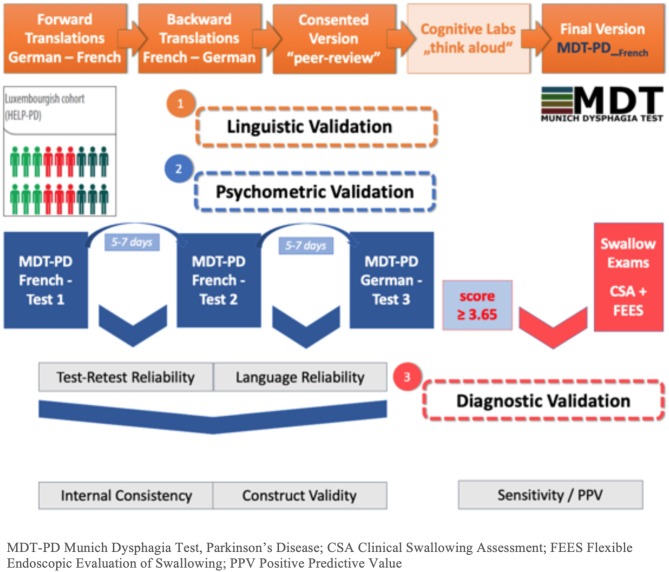
Flowchart of study phases. MDT-PD, Munich Dysphagia Test–Parkinson's Disease; CSA, Clinical Swallowing Assessment; FEES, Flexible Endoscopic Evaluation of Swallowing; PPV, Positive Predictive Value.